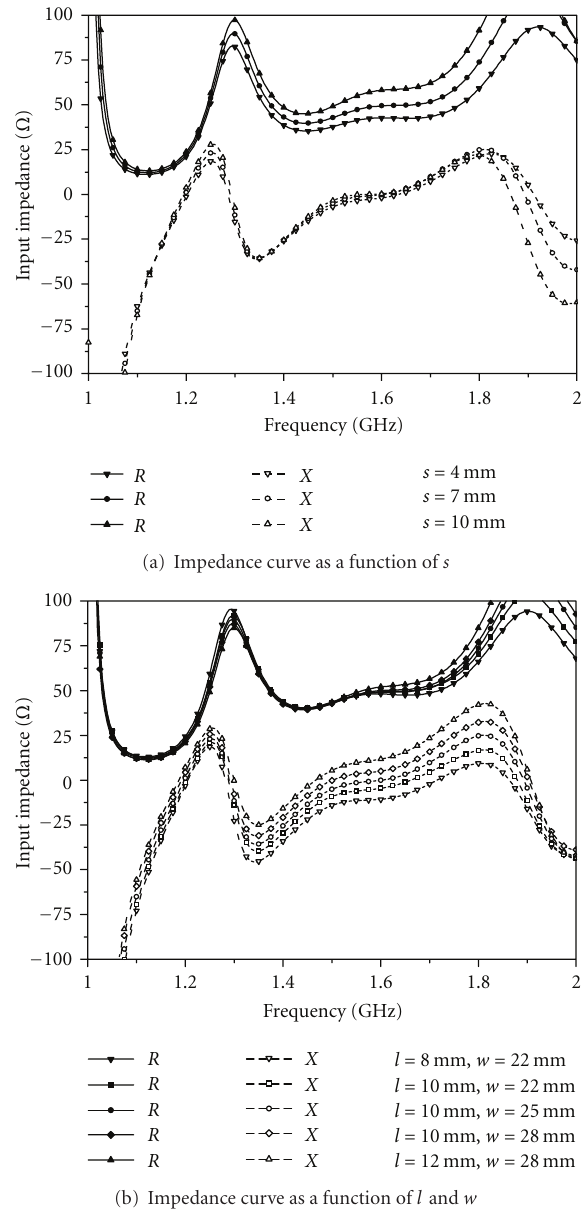
Figure 3: E ff ect of copper strip match stub position and size on input